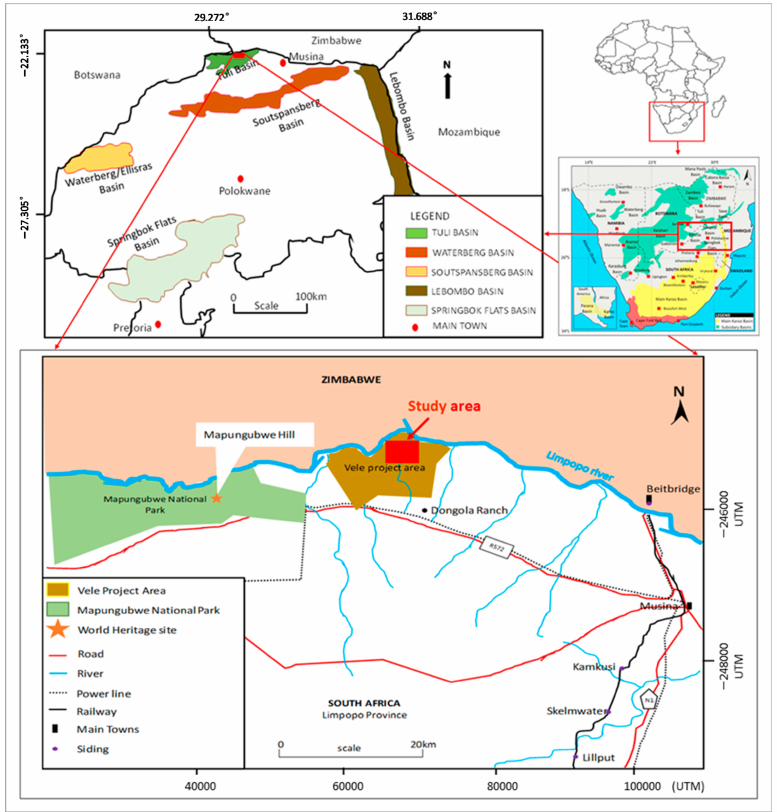
Figure 1. Map showing the Limpopo Karoo basins and location of the study area within the Vele Colliery (after